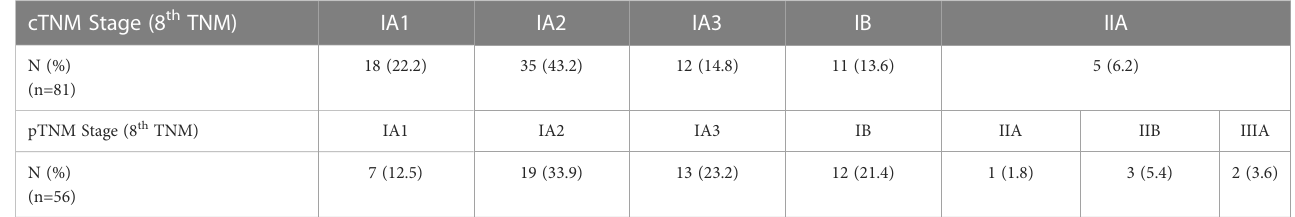
TABLE 2 cTNM and pTNM